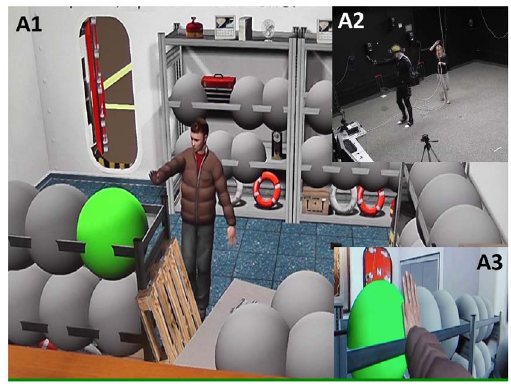
Figure 1. Full immersion VR experiment. The virtual environ- ment (A1, bird’s-eye view) is rendered in real time (A3, ego view) and shown to the subject via a high resolution head- mounted display (A2, physical